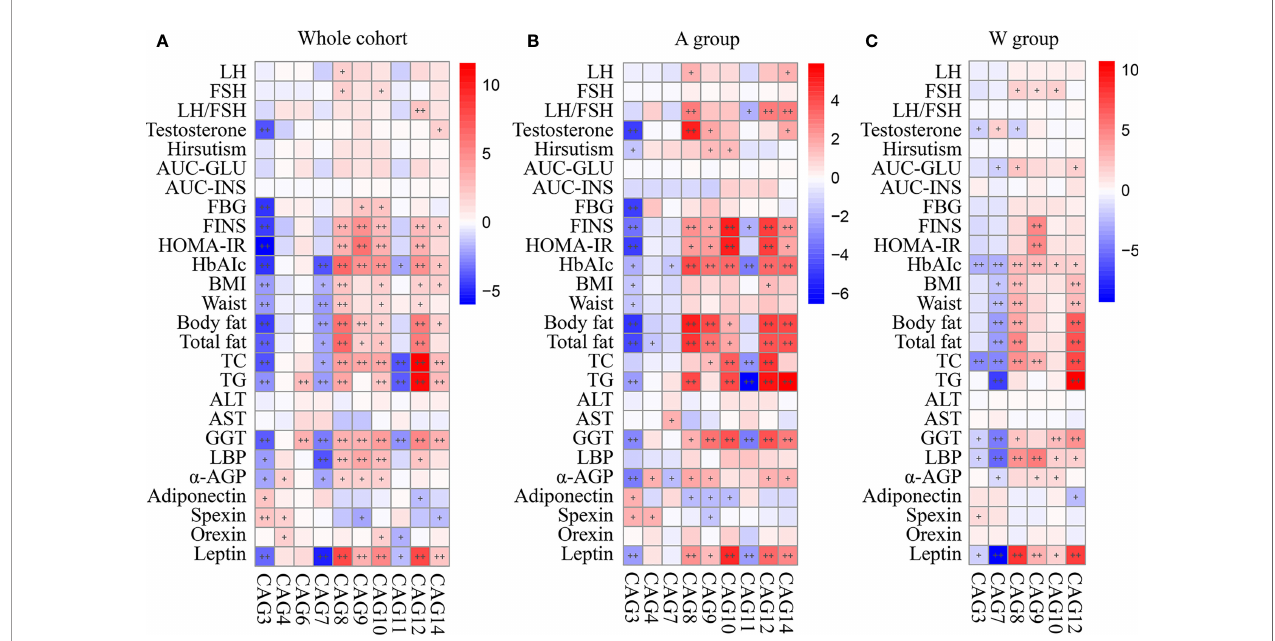
FIGURE 6 | Correlations between primary clinical parameters and altered CAGs in (A) the whole cohort, (B) A group, and (C) W group. In the heat map, spots color represents R-value of MaAslin2 correlation between each CAG and clinical parameter. + FDR < 0.25 and ++ FDR < 0.1. LH, luteinizing hormone; FSH, follicular stimulating hormone; AUC-Glucose, the glucose area under the curve of OGTT; AUC-Insulin, the insulin area under the curve of OGTT; FBG, fasting blood glucose; FINS, fasting plasma insulin; HOMA-IR, homeostasis model assessment for insulin resistance index; HbA1c, hemoglobin A1c; BMI, body mass index; TC, total cholesterol; TG, triglyceride; ALT, alanine aminotransferase; AST, aspartate transaminase; GGT, g -glutamyltransferase; LBP, lipopolysaccharide-binding protein; a -AGP, a -1-acid